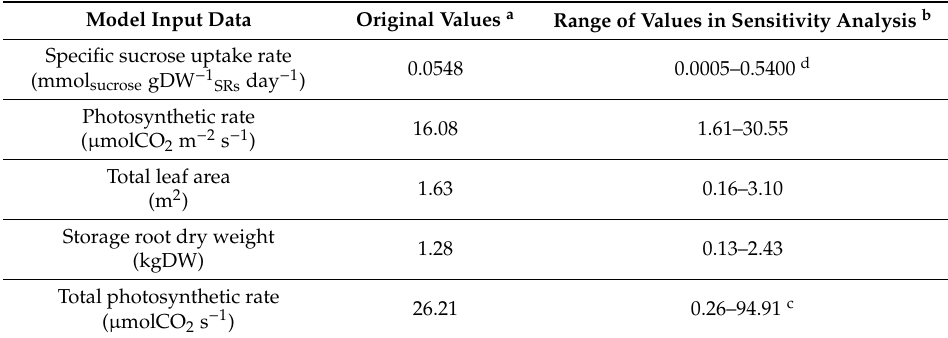
Table 1. The range of the substrate–uptake rate-related data in the rMeCBM-KU50 model.